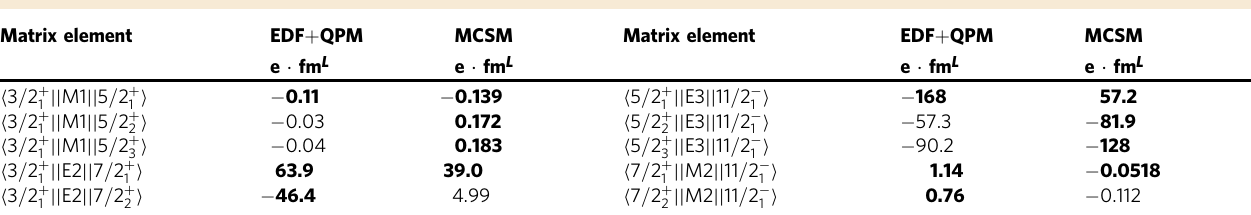
Table 2 Calculated matrix elements. Matrix